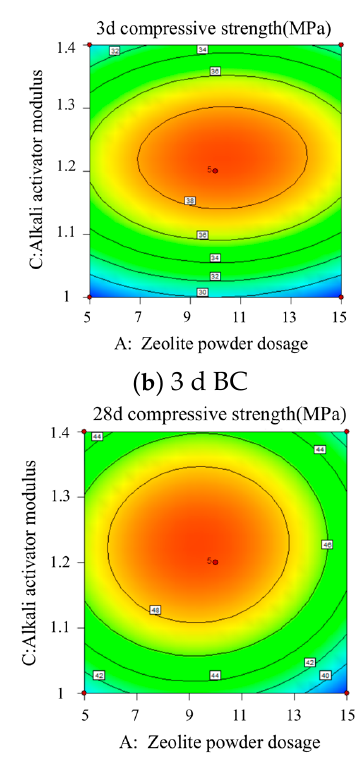
Figure 8. Contour plot for the experimental model.